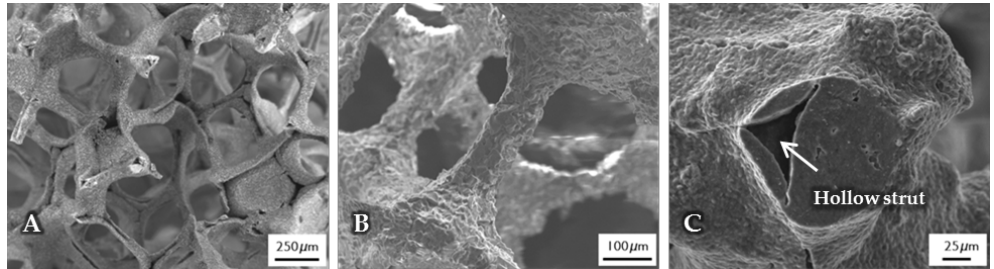
Figure 1. SEM images of as-fabricated bioactive glass-based scaffolds after sintering, at lower ( A